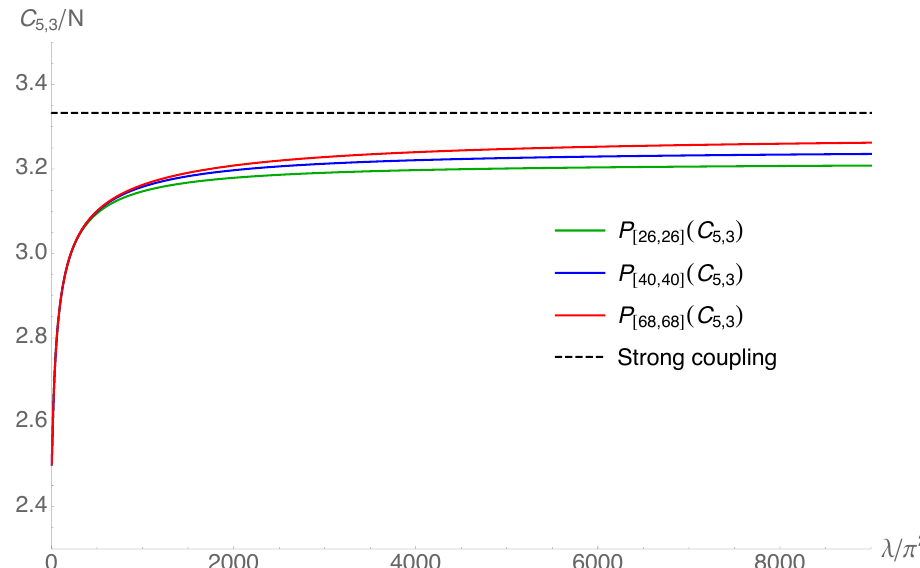
Figure 8 . Comparison between the Padé curves P (blue curve), M = 68 (red curve) and the large- λ theoretical prediction (4.23) (black dashed curve) for the mixing coefficient C 5 , 3 divided by N .